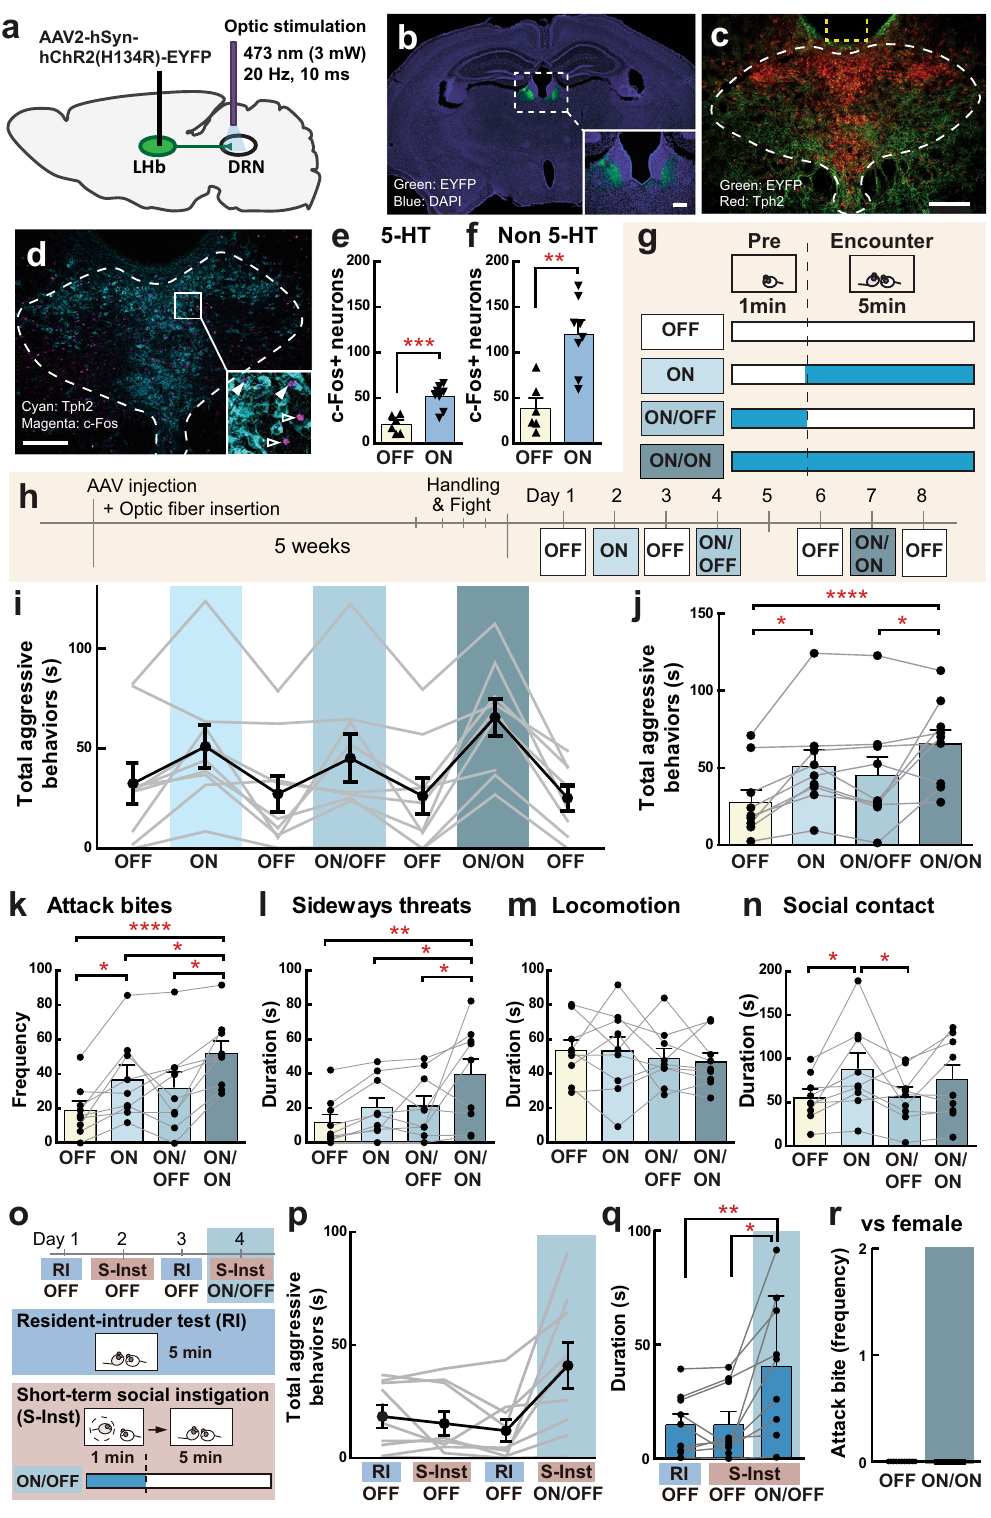
Green: EYFP Red: Tph2